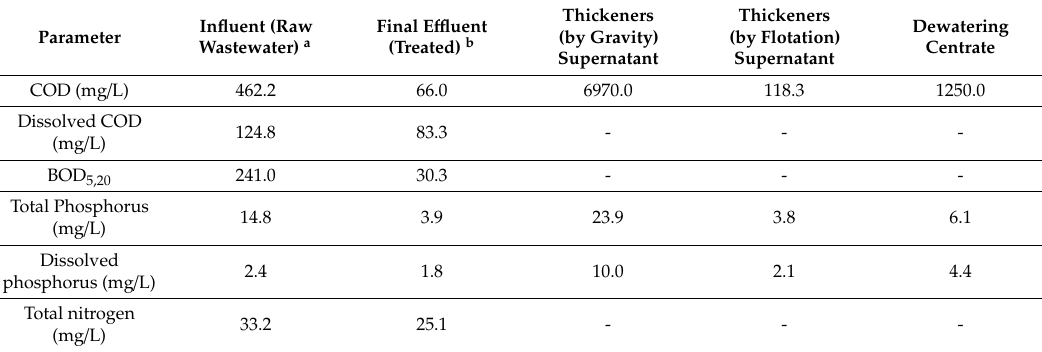
Table 4. Mean concentration of main parameters at di ff erent sampling